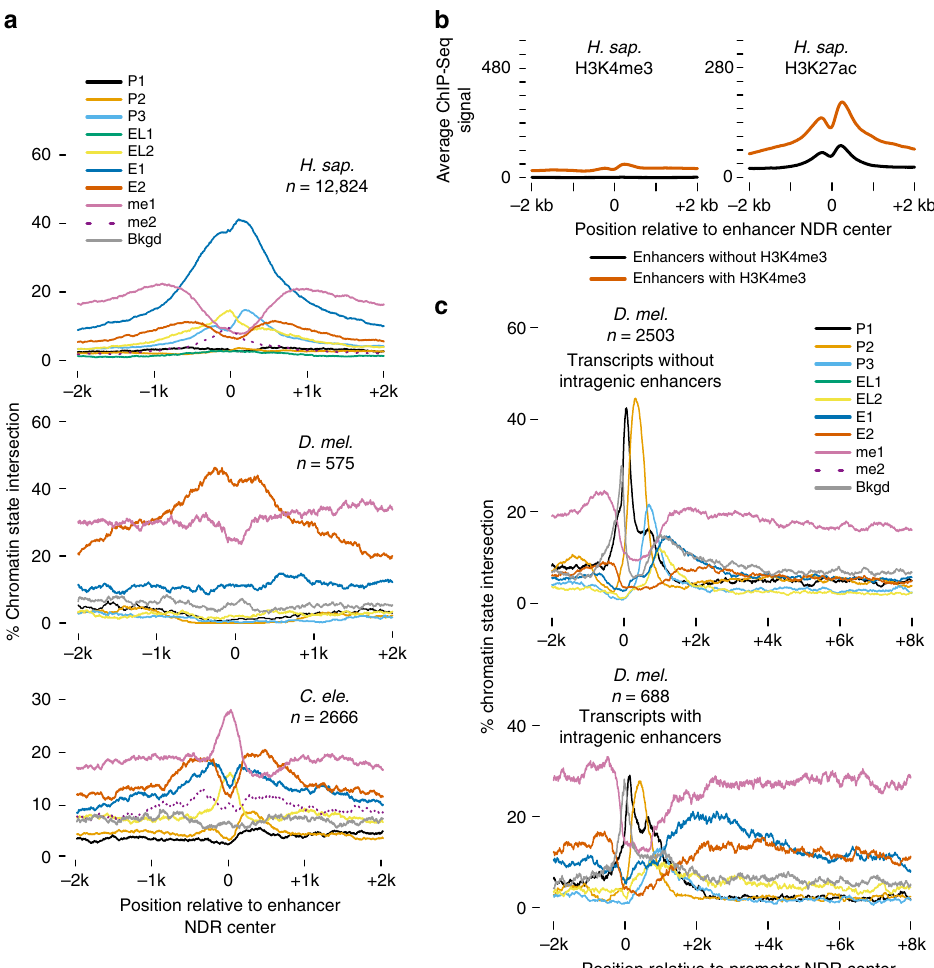
Fig. 5 Variation of enhancer chromatin architecture across species. a Chromatin state (see Fig. 3a) positional coverage for enhancer NDRs (intergenic NDRs that intersect at least H3K4me1 and H3K27ac). b Average normalized ChIP-Seq signal for H3K4me3 (left) and H3K27ac (right) at human enhancer regions that either intersect or do not intersect H3K4me3 ( n = 6537 and n = 6287, respectively). c Chromatin state positional coverage for expressed promoters whose transcripts are either without (top) or with (bottom) intragenic NDRs that intersect STARR-seq